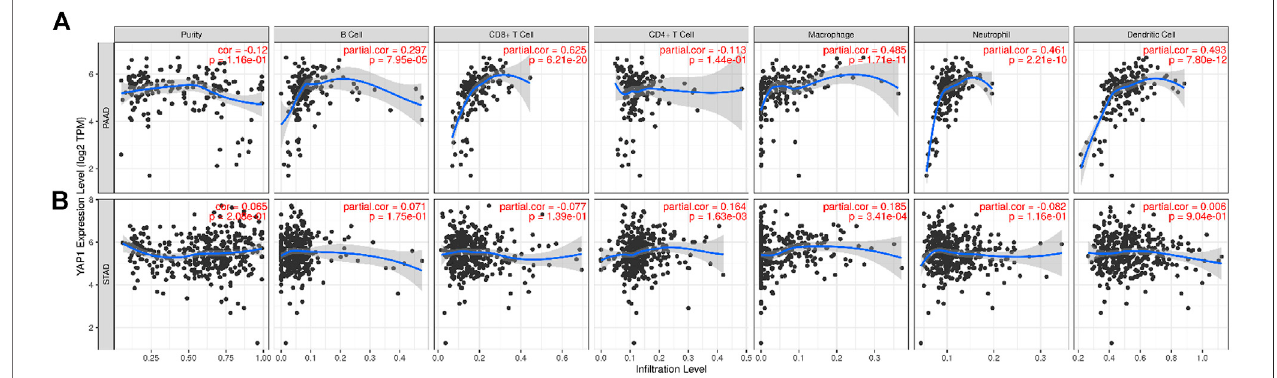
FIGURE 7 | Correlation between YAP1 expression and immune cell in fi ltration in pancreatic adenocarcinoma (PAAD) and stomach adenocarcinoma (STAD).